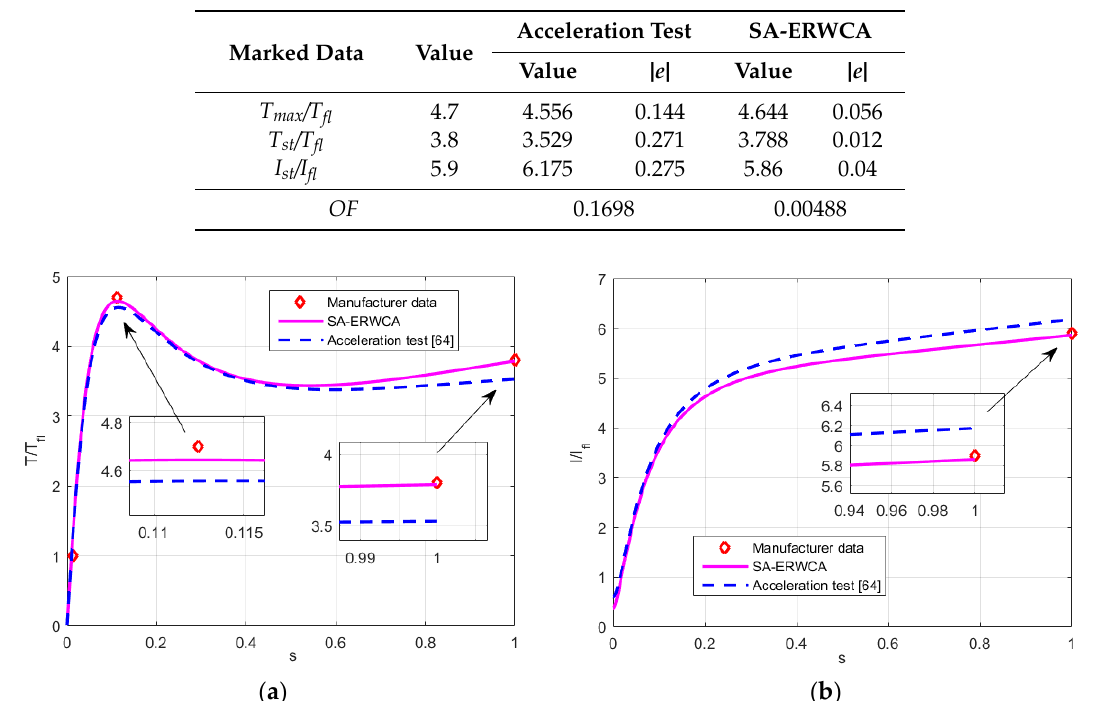
Figure 7. Curves of Machine 3: ( a ) Torque versus slip; and ( b ) phase current versus slip obtained from the acceleration test [64]. Table 17. Data of Machine 4 and measured data: three-phase induction motor [45]. Parameter